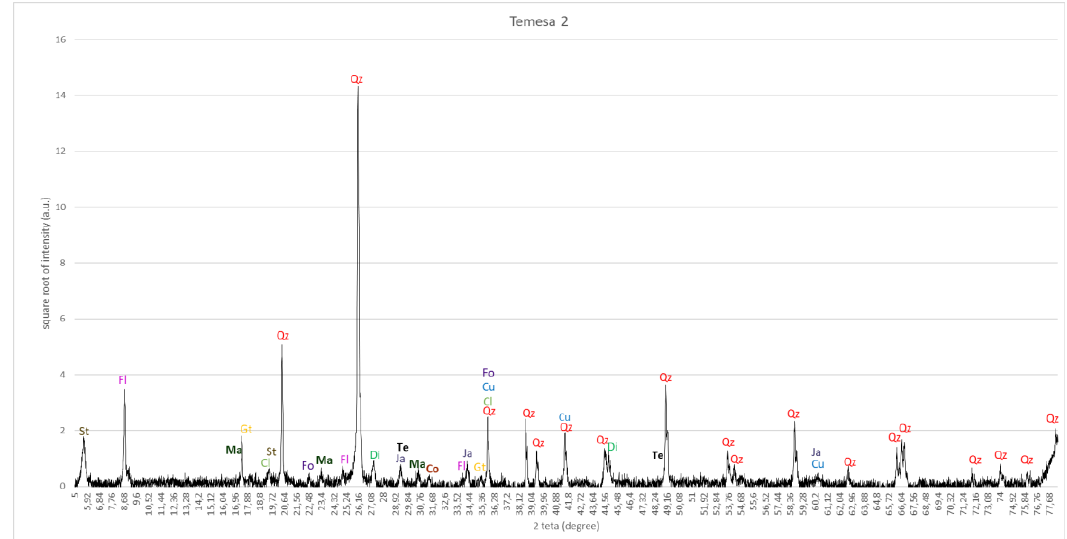
Figure 6. Temesa 2: XRD pattern. Abbreviations: St — stevensite, Fl — phlogopite, Gt — goethite, Cl — chloritoid, Qz — quartz, Di — digenite, Ma — malachite, Cu — cuprite, Fo — fosterite, Te — tetraedrite, Ja — jacobsite, Co — covellite. Square-root intensity scale.